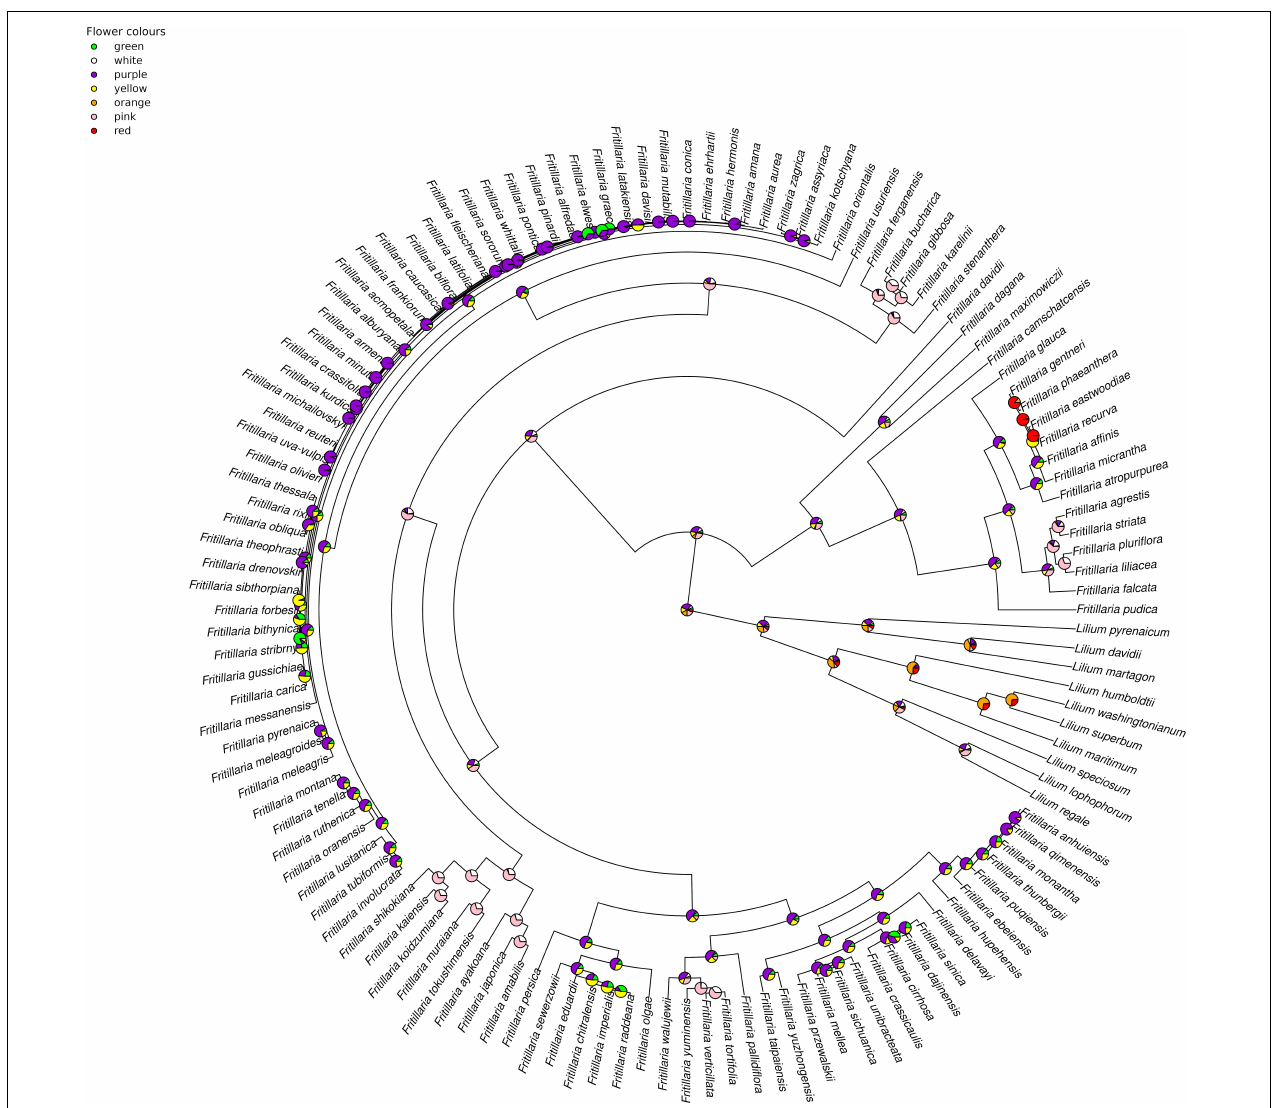
FIGURE 4 | Estimation of ancestral states of flower colours among studied Fritillaria species calculated using maximum likelihood. Pie charts represent the proportion of the likeliest state at each internal